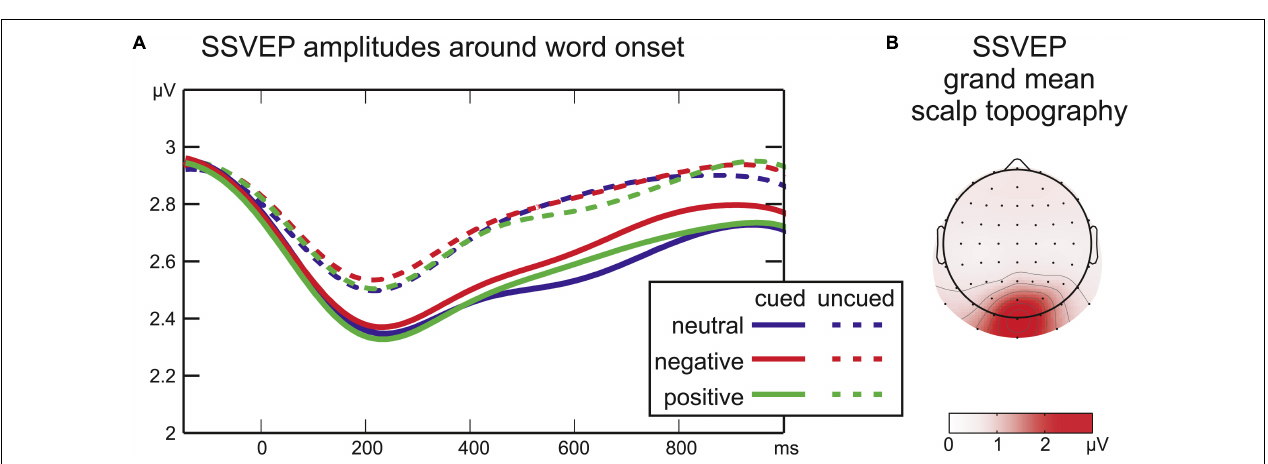
FIGURE 3 | (A) Time courses of SSVEP amplitude after word onset. The cue period was analyzed separately (cued trials only, not depicted). (B) Grand mean SSVEP amplitude across all conditions from –350 to 1200 ms around word